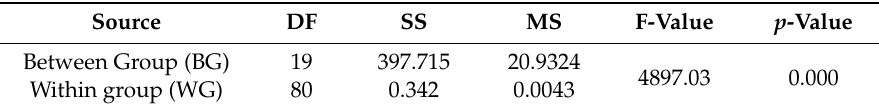
Table 5. The ANOVA test results of tensile modulus.